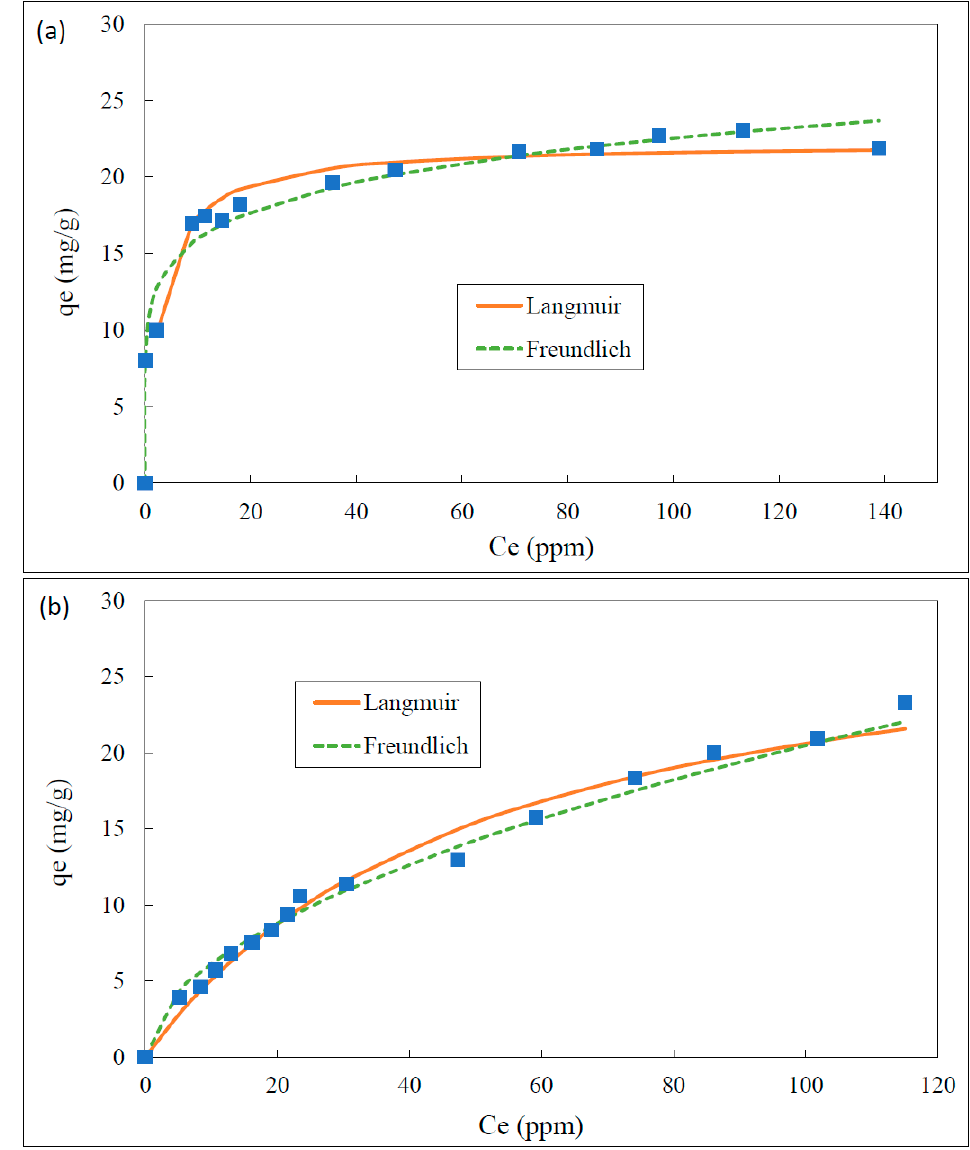
Figure 8. Cobalt ( a ) and lithium ( b ) adsorption isotherms at 25 °C using 13XBFK.